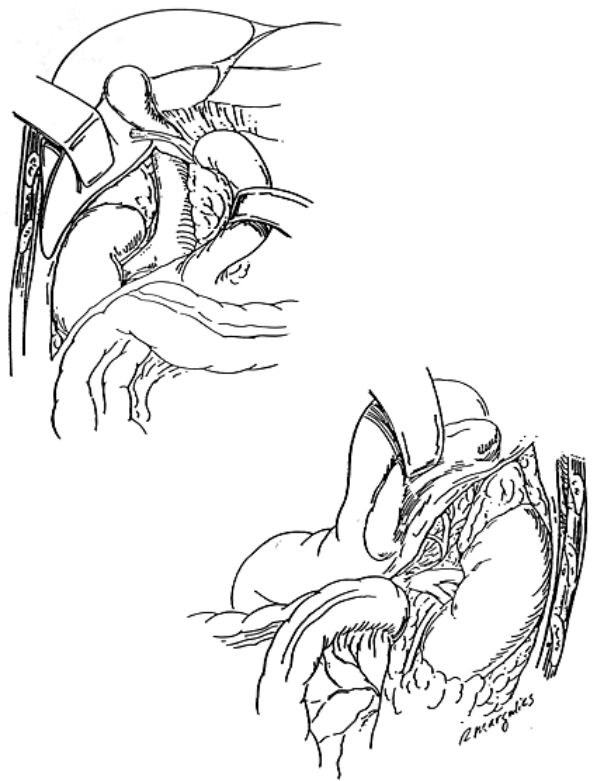
FIGURE 11. Relationship of the adrenal to intra-abdominal organisms. Care should be taken to avoid injury to the spleen, splenic vein and pancreas on the left and the liver and duodenum on the